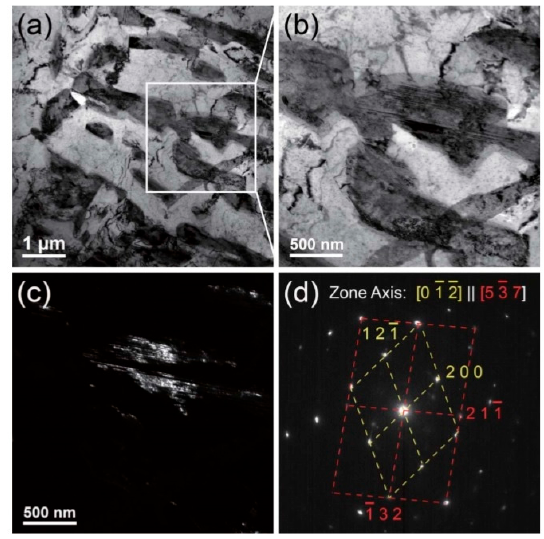
Figure 10. TEM micrographs showing the fine structure of M/A phases in NiCu steel after tempering at 720 °C. ( a ) Bright-field image at low magnification, ( b ) bright-field image, ( c ) dark-field image, and ( d ) electron diffraction pattern.